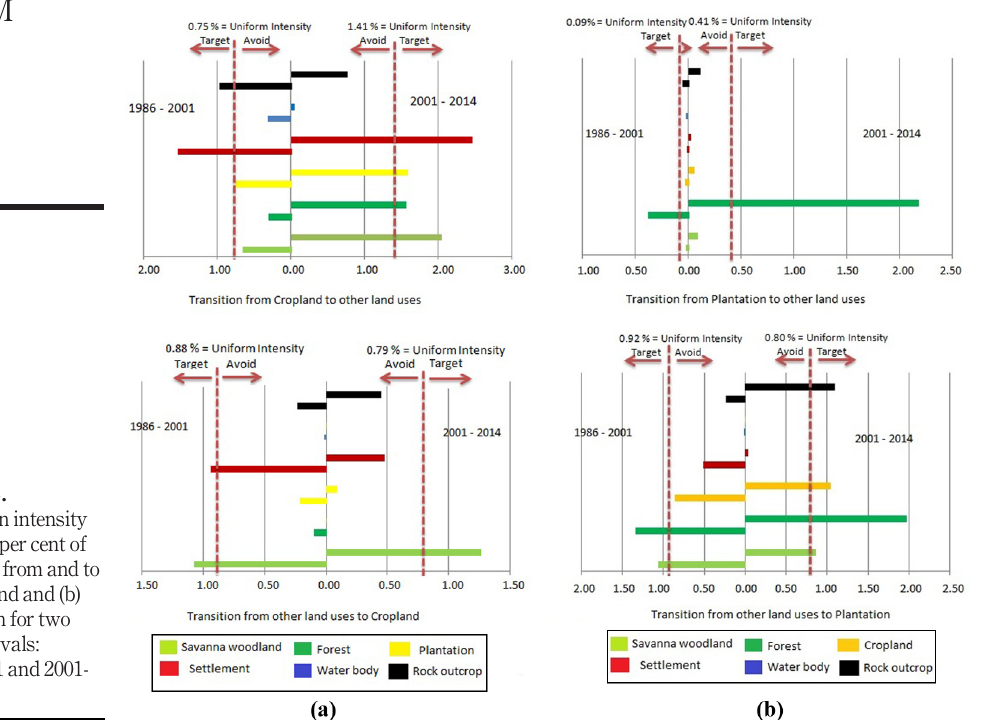
Figure 5. Transition intensity analysis (per cent of category) from and to (a) cropland and